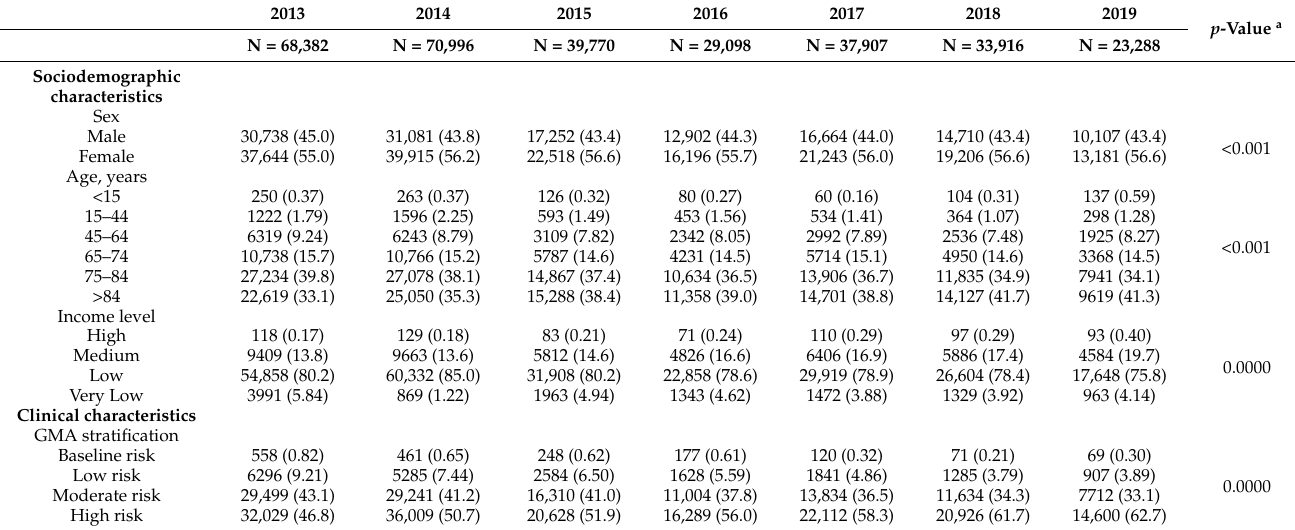
Table 2. Evolution of the sociodemographic and clinical characteristics of complex chronic patients throughout the study period, n